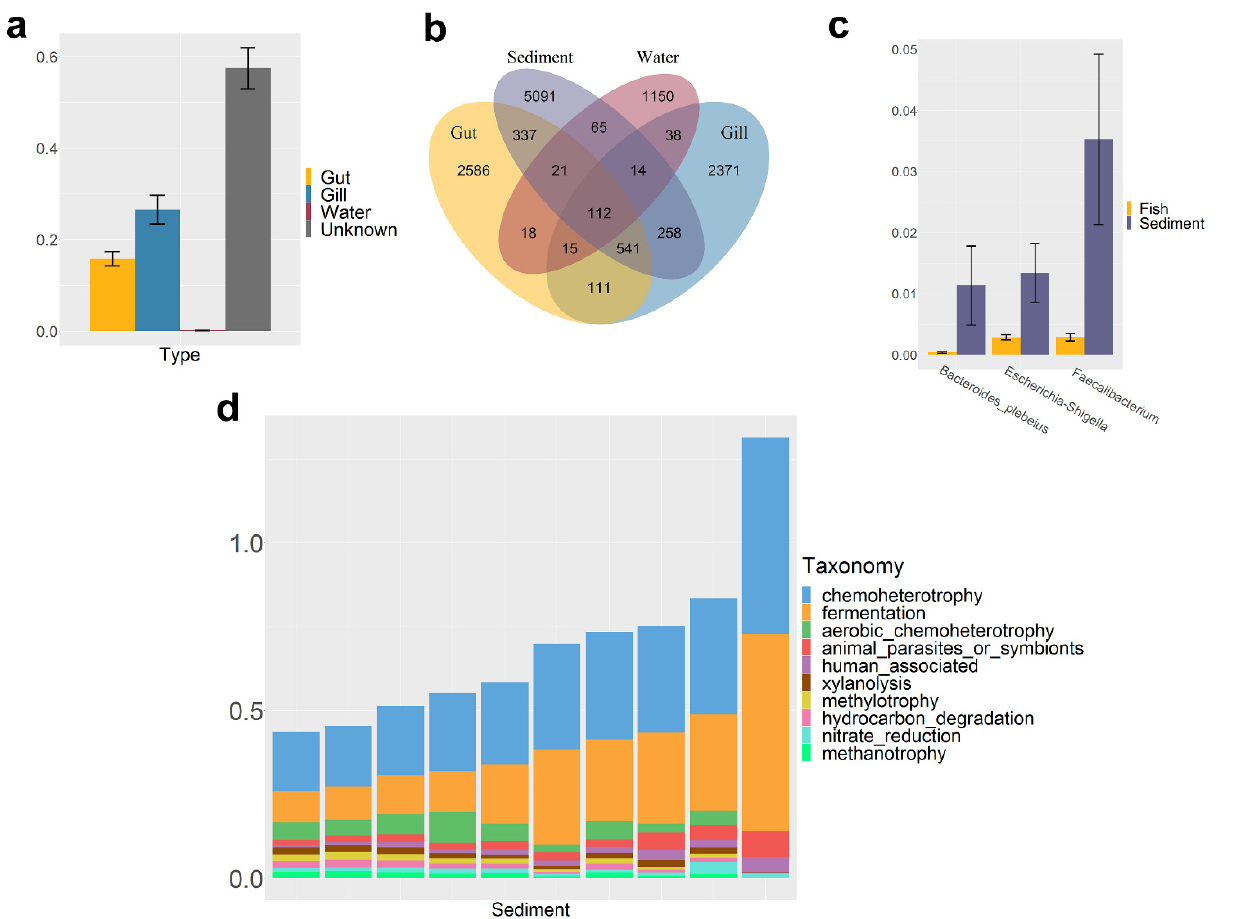
Figure 5. Characteristics of sediment microbiota. ( a ) SourceTrack analysis of sediment microbiota; the vertical axis represents the mean value of microbiota from potential sources, the error bars represent the standard error (SE); ( b ) Venn plot of shared and unique ASVs between fish and the environment; ( c ) Significantly enriched microbiota in the sediment; the p value of the Kruskal–Wallis test was less than 0.05, and the average proportion in the sediment was more than 1%; the vertical axis represents the average of the three microbes, and the error bars represent the standard error (SE); ( d ) Top 10 predicting functions of sediment microbiota; the vertical axis represents the average proportion of each